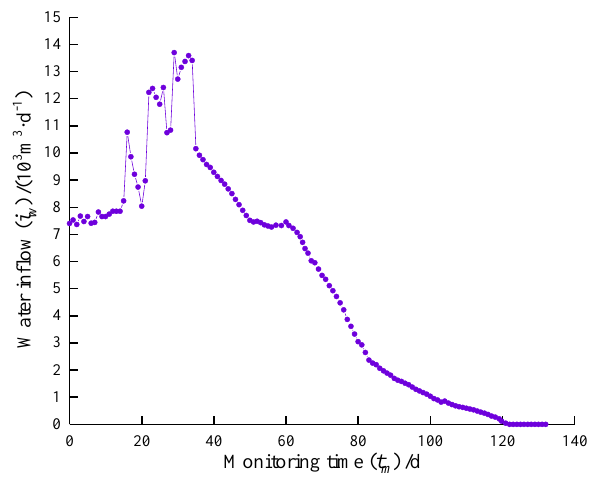
Figure 14. Change of water inflow from July 1 to November 10 in 2020.